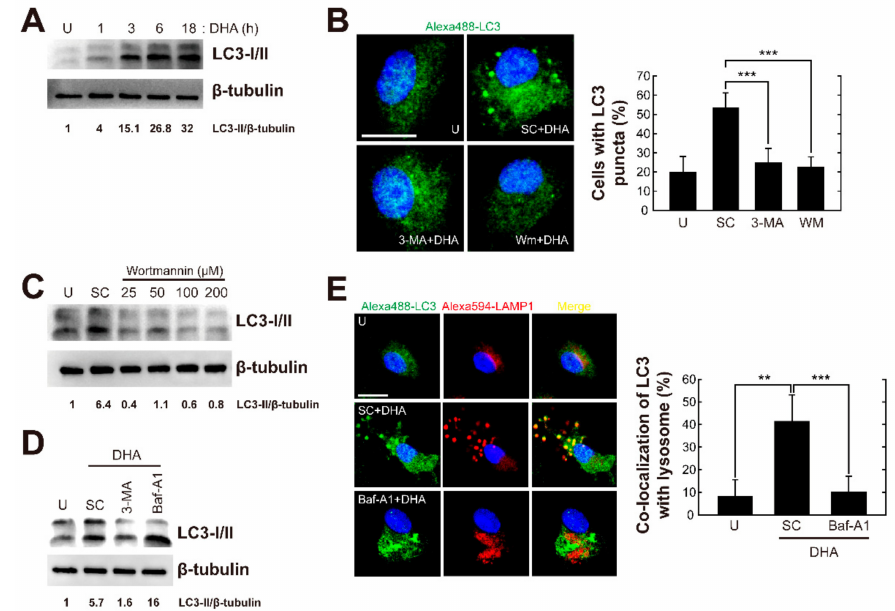
Figure 3. DHA induces autophagy activation in primary macrophages. ( A ) BMDMs were treated with DHA (10 µ M) for the indicated time periods and subjected to immunoblot analysis of LC3 and β -tubulin. ( B – E ) BMDMs were treated with 3-MA (10 µ M), Baf-A1 (100 nM), or increasing concentrations of WM (25, 50, 100, or 200 nM), and then incubated with DHA for 18 h. ( B ) Alexa 488-conjugated LC3 (green) and DAPI (blue) were detected by confocal microscopy. Merged signals of LC3 puncta formation and DAPI (left). Quantitative analysis of the percentage of cells with LC3 puncta (right). Scale bar: 10 µ m. ( C and D ) Cell lysates were subjected to immunoblot analysis of LC3 and β -tubulin. ( E ) Alexa 488-conjugated LC3 (green) and Alexa 594-conjugated lysosome-associated membrane glycoprotein 1 (LAMP1, red) and DAPI were detected by confocal microscopy. Merged signals of LC3, LAMP1, and DAPI (left). Quantitative analysis of cells showing colocalization of LC3 with LAMP1 (right). Scale bar: 10 µ m. Each immunofluorescence microscopic experiment included at least 100 cells scored in 5 random fields. Data are representative of three independent experiments and are presented as means ± SD. ** p < 0.01, *** p < 0.001 (two-tailed Student’s t-test). U, untreated; SC, solvent